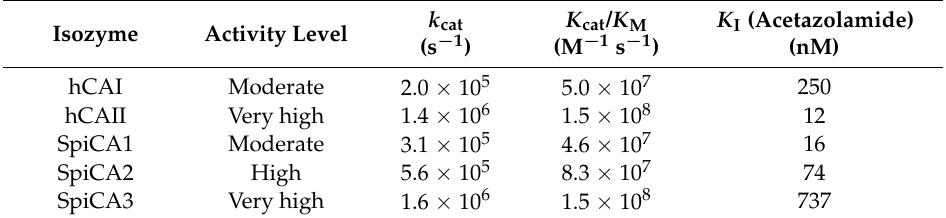
Table 1. Kinetic parameters for the CO 2 hydration reaction catalyzed by the human cytosolic α-hCA isozymes I-II, and the coral enzymes SpiCA1-3, at 20 °C and pH 7.5 in 10 mM HEPES buffer, and their inhibition data with acetazolamide (5-acetamido-1,3,4-thiadiazole-2-sulfonamide), a clinically used drug.